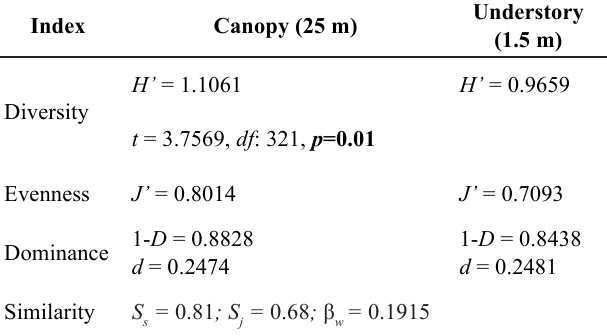
Table 3. Ecological indices for assemblage of male euglossine bees in each arboreal stratum. H ’ = Shannon-Wiener; t =